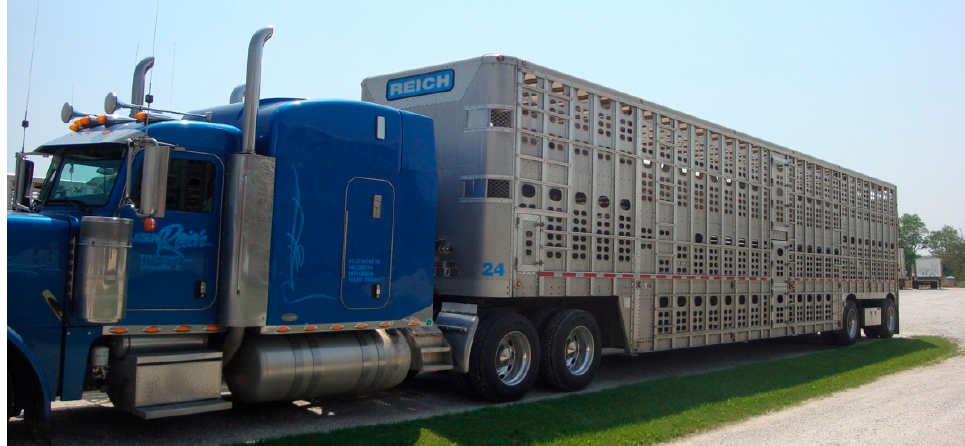
Figure 1. Trailer used for trailer environment monitoring in this field study. The same trailer was instrumented and utilized for all monitoring of trailer interior environment during all commercial market-weight pigs transport throughout this study.